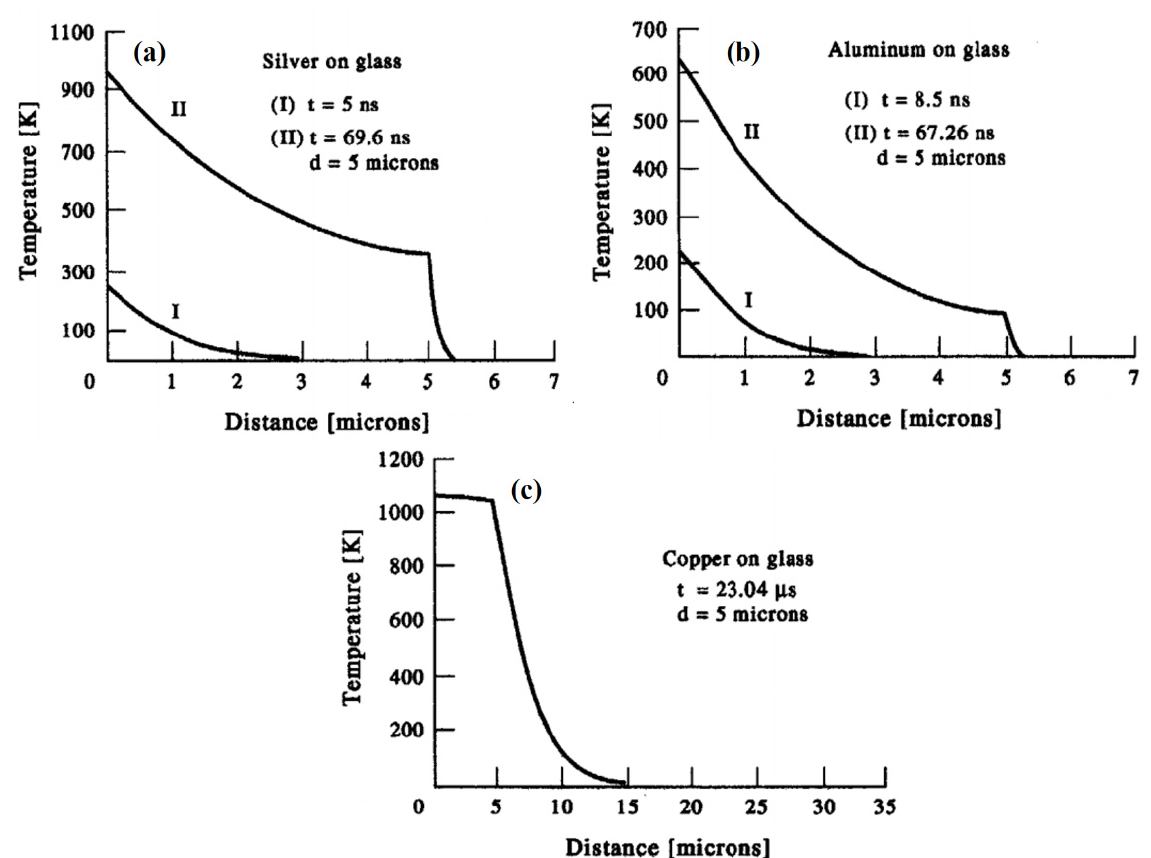
Figure 5. Temperature profile within a two-layer system with constant surface absorptance ( a ) silver thin film deposited on glass substrate at: (I) t = 5 ns; (II) t = 69.6 ns, ( b ) aluminum thin film deposited on glass substrate at two different exposure times: (I) t = 8.5 ns; (II) t = 67.26 ns, and ( c ) copper thin film deposited on glass substrate at exposure time t = 23.04 µs [38]; with permission from Elsevier.